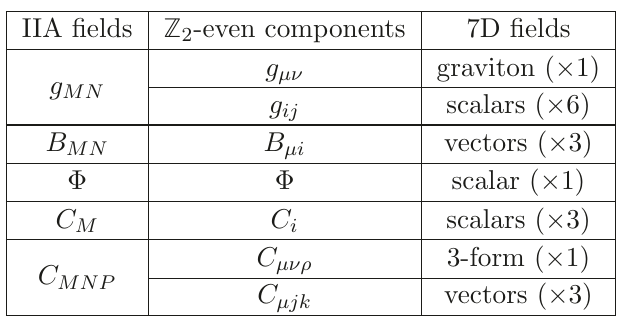
Table 1 . The effective 7D bosonic field content of type IIA supergravity on a compact 3d manifold. Please note that the orientifold truncation selects the field components which are even w.r.t. the O6 projection. After dualizing the 3-form into a 2-form, the counting exactly matches the